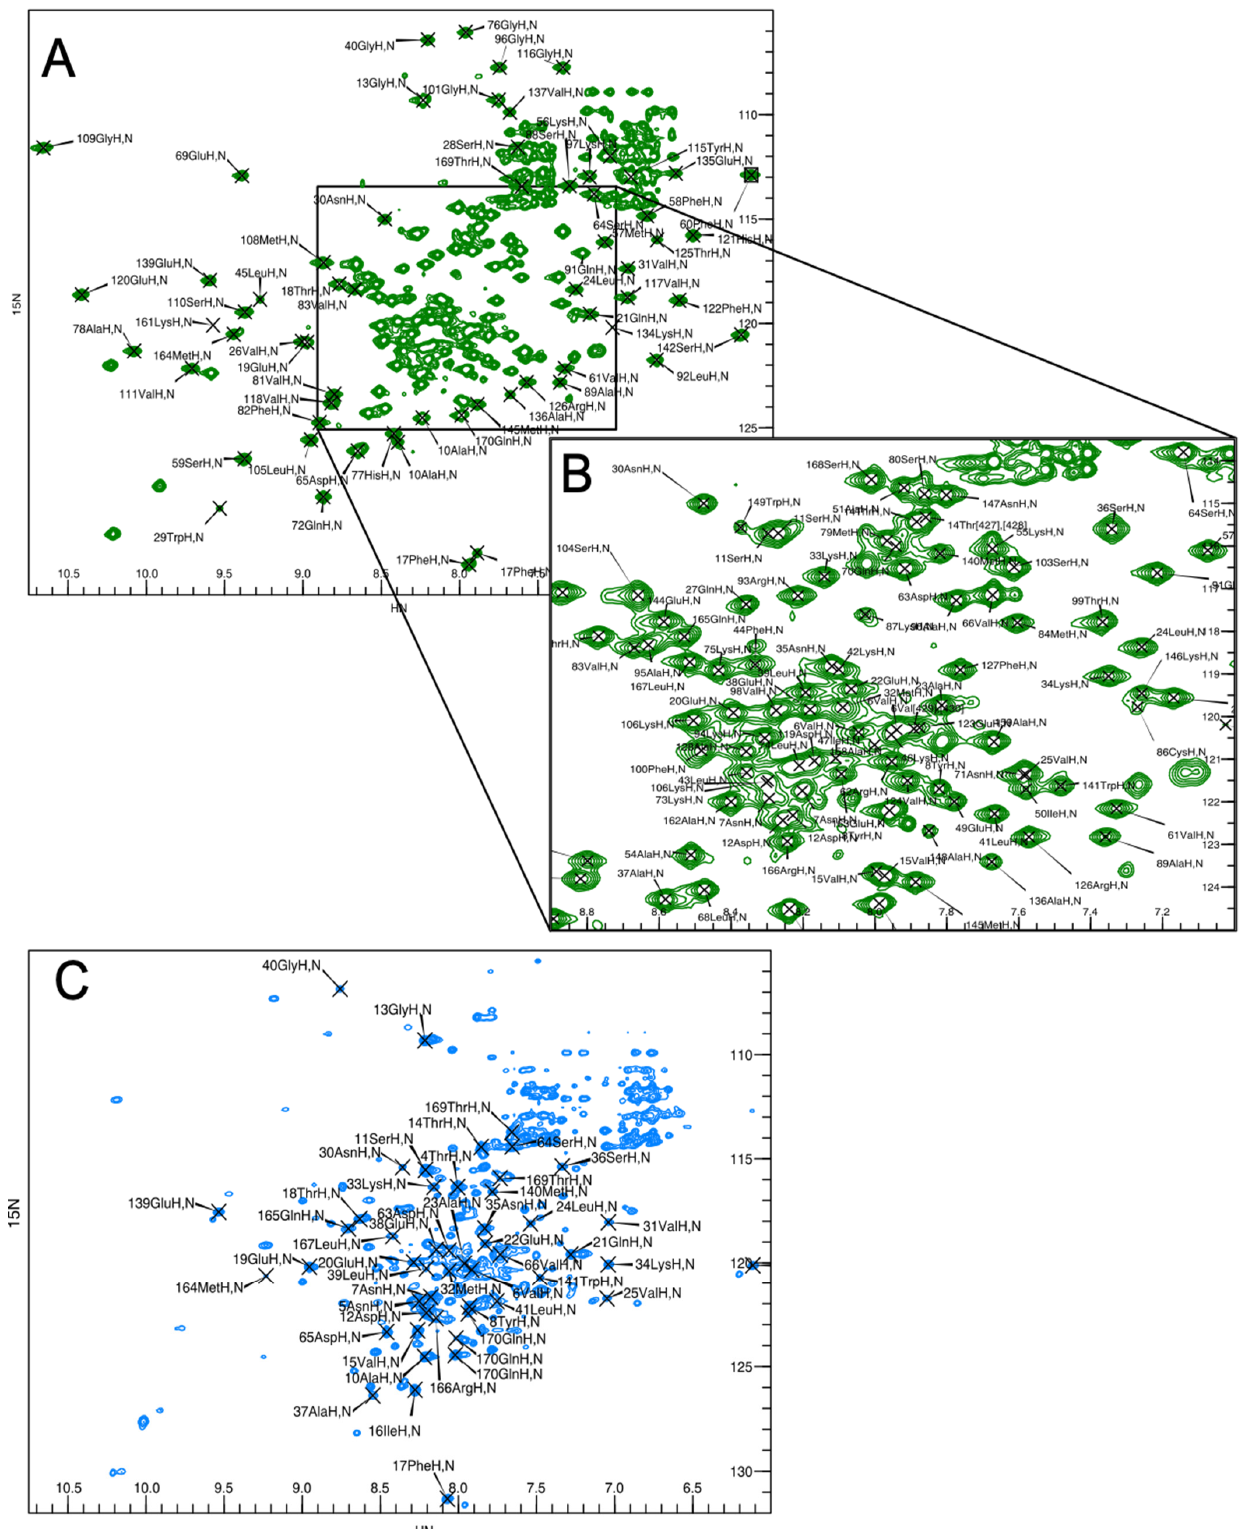
Figure 1. 1 H– 15 N-TROSY spectra with assignments for BvPgb1.2 in complex with cyanide ( A , B ) and oxygen ( C ). The spectra were acquired at 298 K and a magnetic field strength of 18.8 T. Panel B is a close-up of the boxed area in panel A.